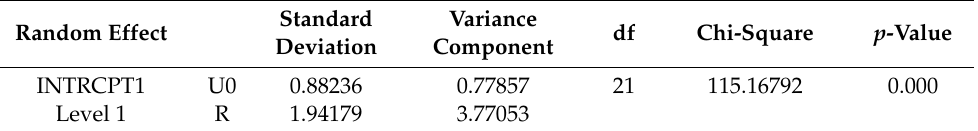
Table 5. Final estimation of variance components.